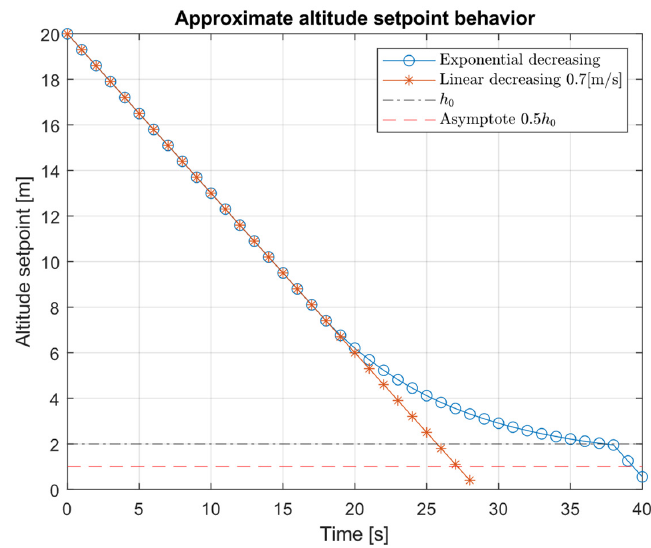
Figure 4. Approximate altitude setpoint evolution.